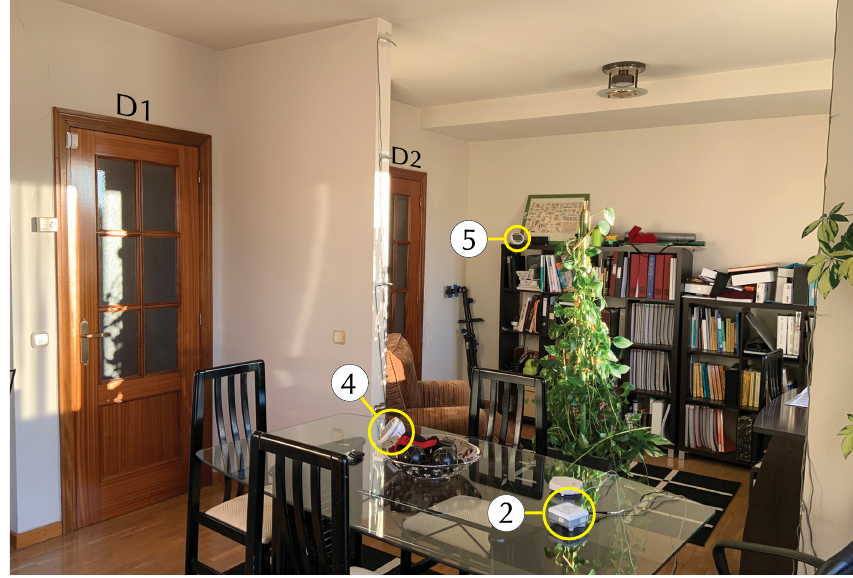
Figure 4. Northeast side view of the room. D, door; numbers are CO 2